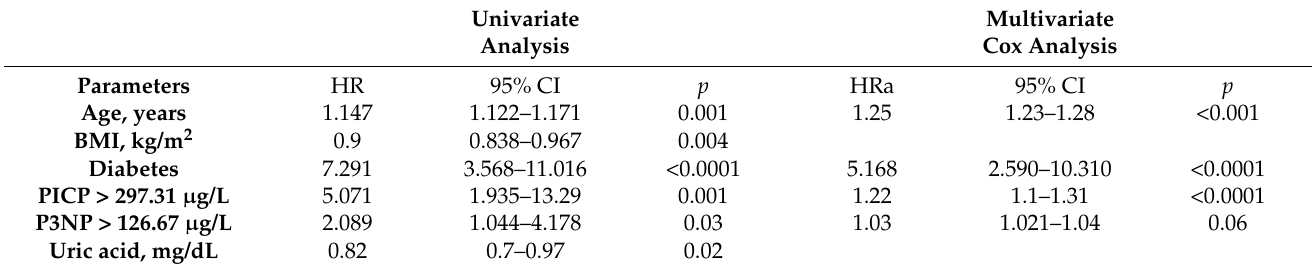
Table 3. Univariate analysis and multivariate Cox proportional hazards